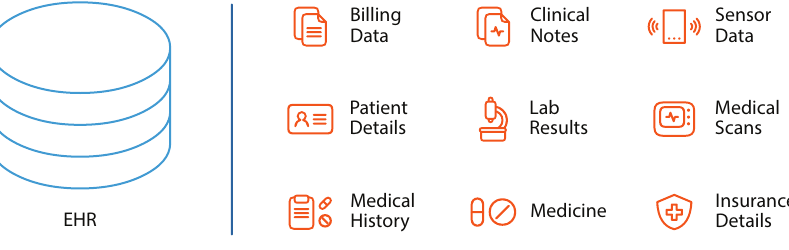
Figure 1. Overview of Electronic Health Records (EHRs)